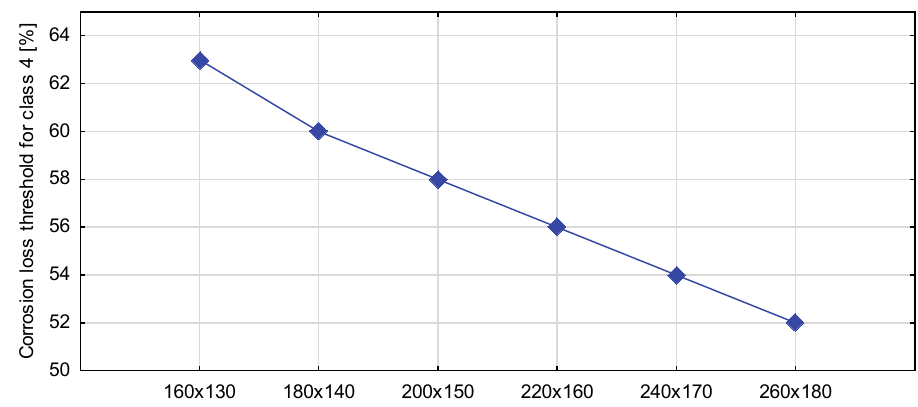
Fig. 4. The degree of corrosion loss at which the profile moves from the third to fourth class, depending on its size